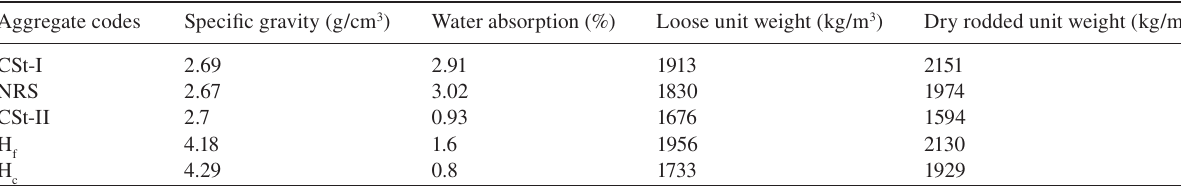
Table 1 Physical properties of aggregates.